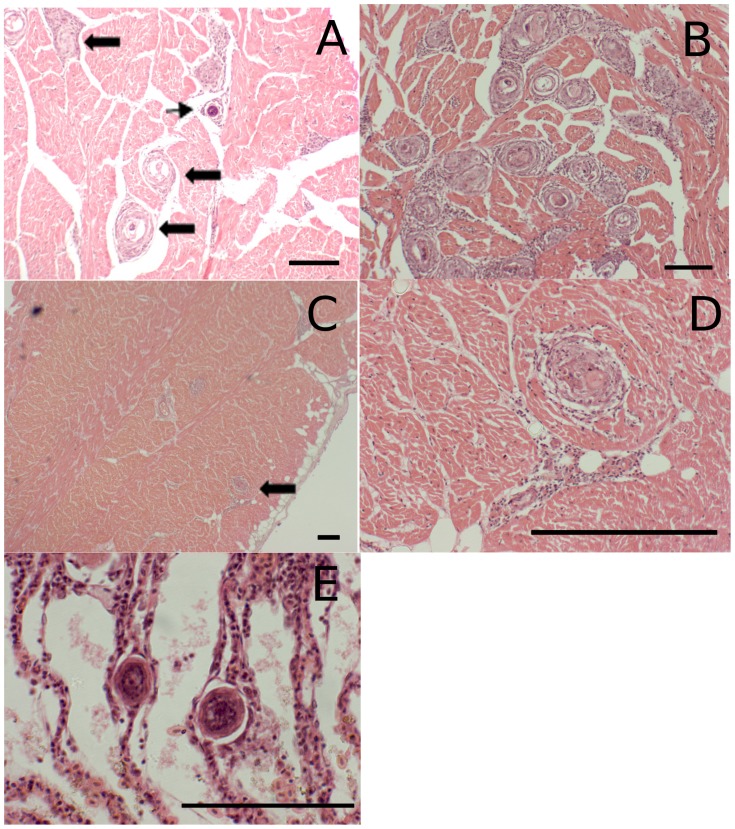
Presence of C. forsteri eggs in T. maccoyii organs H&E staining (A) within the spongiosa of the heart ventricles, eggs (small arrow) and granulomas (large arrow); (B) large number of granulomas associated with eggs within the spongiosa of the heart; (C & D) granuloma associated with eggs in the compacta of the heart ventricles (large arrow); (E) eggs within the lamellae creating a ‘string of pearls’ appearance.Scale bar 100µm.